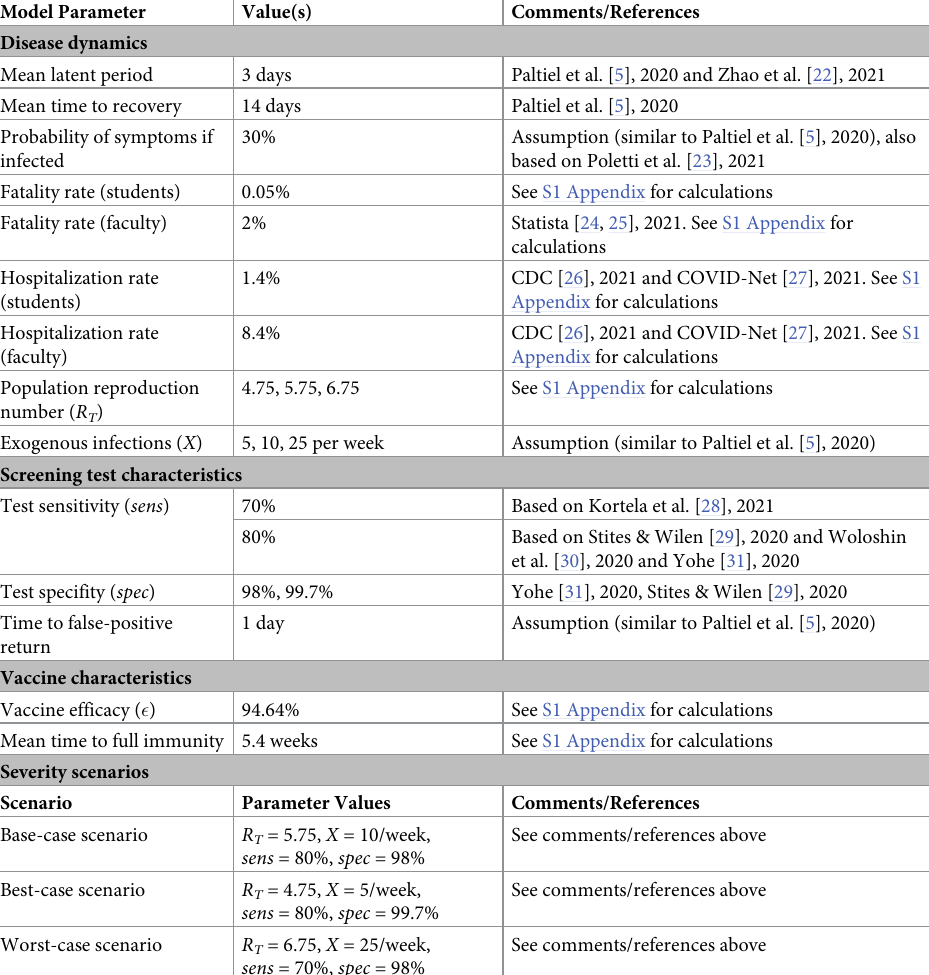
Table 2. Summary of key